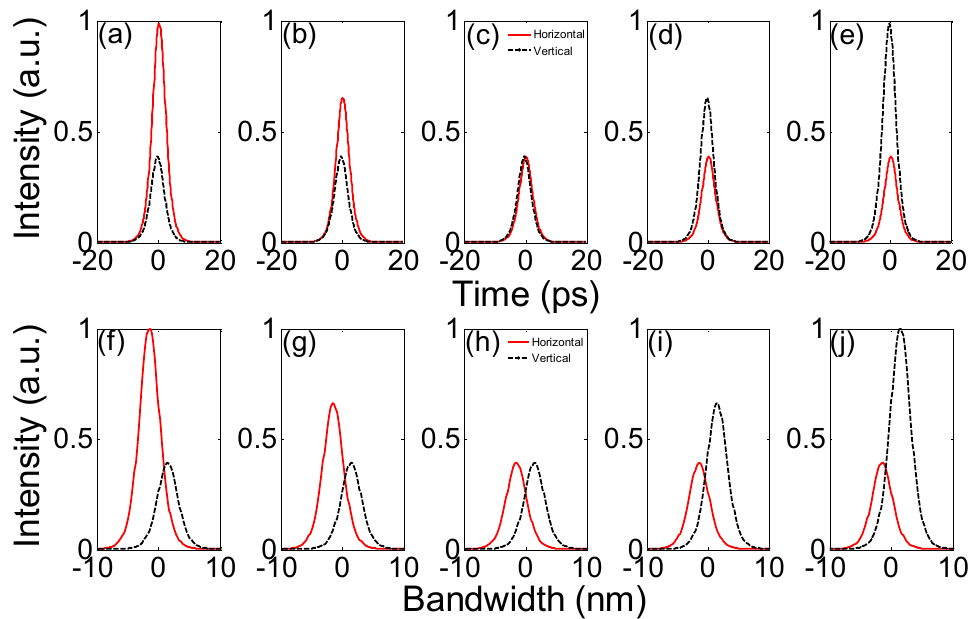
Figure 7. Theoretical results after polarization splitting when amplitude ratio between orthogonal modes is changed and λ 1 = 1063 nm, λ 2 = 1065 nm.